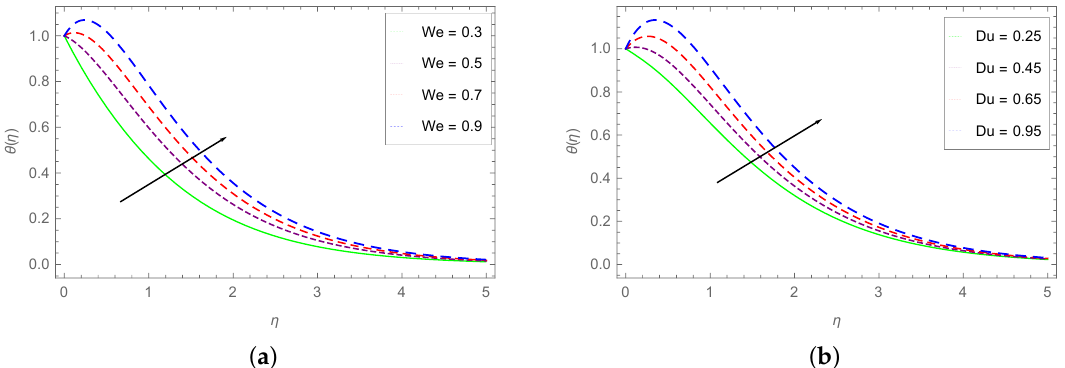
Figure 7. ( a ) θ ( η ) dependence on Pr and ( b ) θ ( η ) dependence on Rd . The influence of augmenting values of Weissenberg number ( We ) and Dufour number ( Du ) on θ ( η ) is displayed respectively in Figure 8a,b. The We and Du values are taken as 0.3, 0.5, 0.7, 0.9 and 0.25, 0.45, 0.65, 0.95, respectively. It is clear that θ ( η ) declines with the augmenting η at constant We . The temperature field profiles of the fluid upsurge with the enhancing We values. This means that the augmenting viscous nature of the Carreau fluid associated with the rising We enhances the fluid temperature. The different θ ( η ) curves overlap beyond η = 4.0. Figure 8b displays the variation of the Carreau fluid temperature with the enhancing Du (Dufour number). It is observed that the fluid temperature profiles rise with the enhancing Du values. Thus, the accumulation of the fluid particles due to increasing Du raises the fluid temperature.